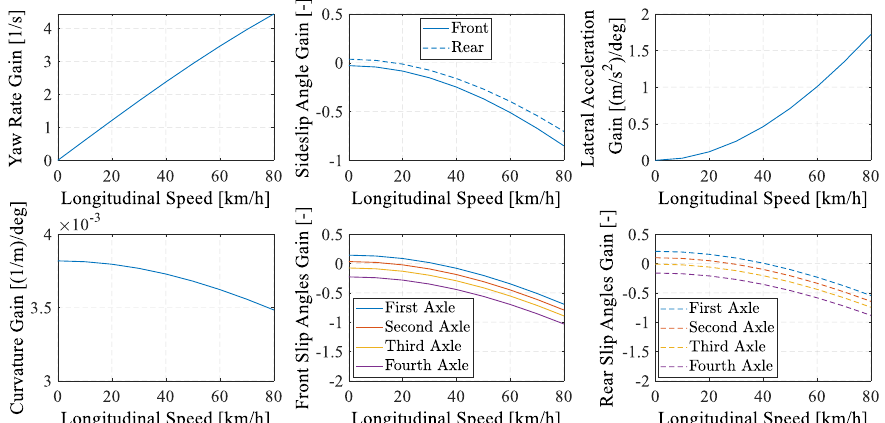
Figure 12. Steady-state gains of yaw rate ( top left ), front and rear sideslip angles ( top central ), front lateral accelerations ( top right ), curvatures ( down left ), front slip angles ( down central ) and rear slip angles ( down right ) for different front longitudinal speeds.